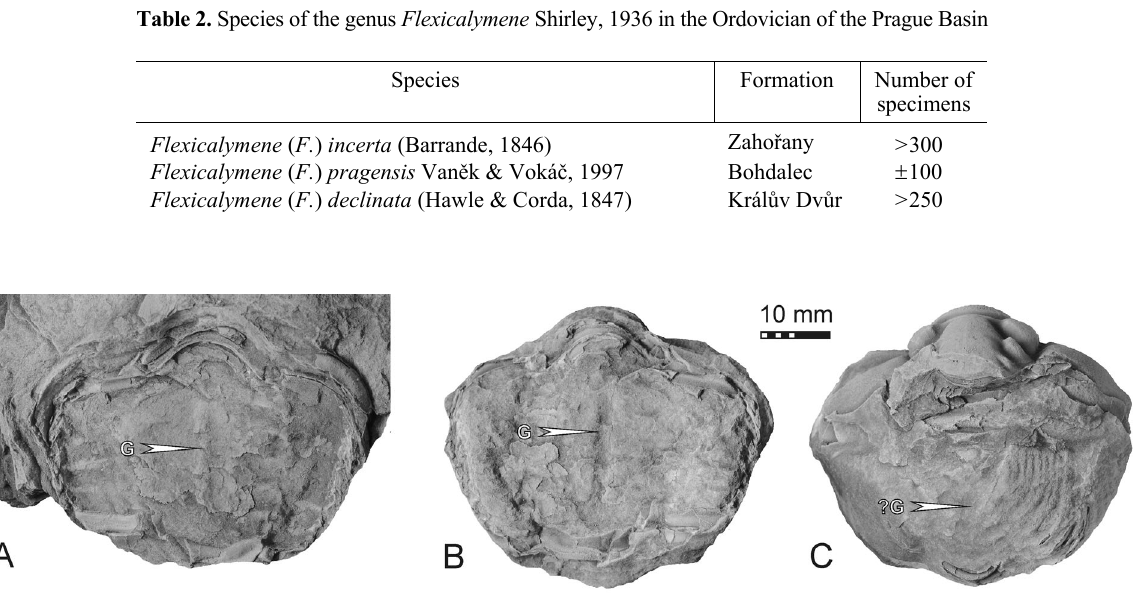
Fig. 5. Morphology of the preserved parts of the digestive system in the thoracic and pygidial regions of Flexicalymene ( F. ) pragensis Van ě k & Voká č , 1997 from the Bohdalec Formation (Upper Ordovician, Katian = Late Berounian Regional Stage); Czech Geological Survey Prague, Č GS MD 007; Brumlovka locality (locality 3 in Fig. 1B). A , B , dorsal views; C , anterior view. Abbreviation: G,